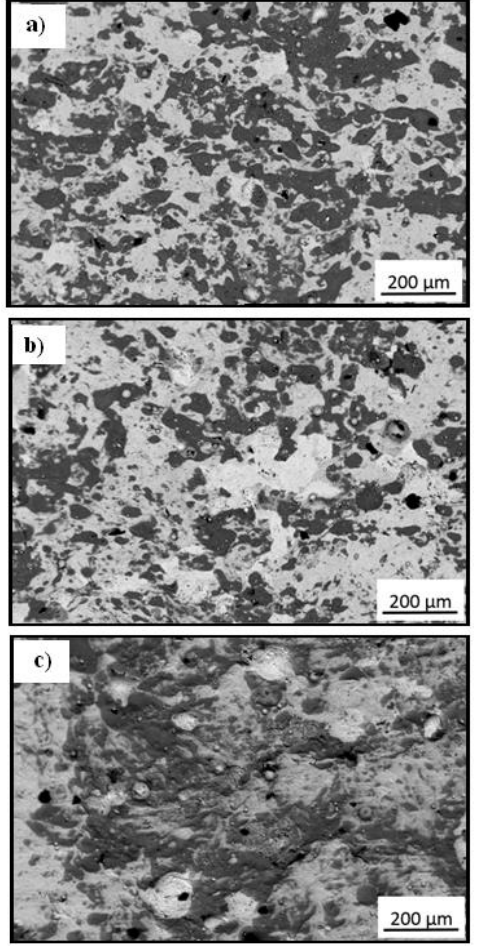
Figure 4. SEM imagesof the Cr 3 C 2 -25(Ni20Cr) cermet coatings on the Al7075 substrate after laser remelting for the spot speed: ( a ) 600 mm/min, ( b ) 800 mm/min, and ( c ) 1000 mm/min.